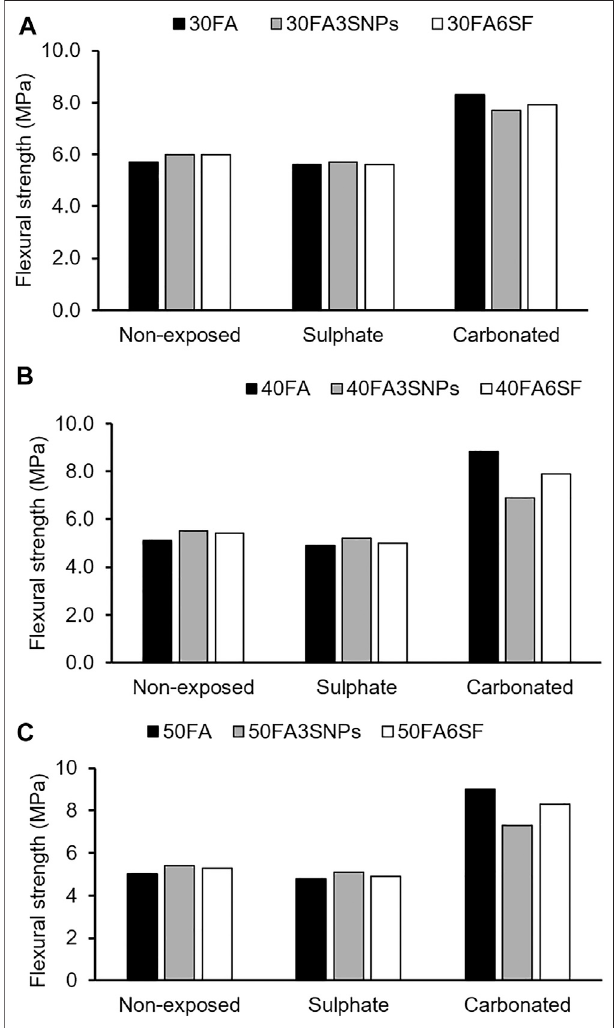
FIGURE 4 | The fl exural strength of exposed and non-exposed (A) 30% fl y ash containing 3% SNPs and 6% SF (B) 40% fl y ash containing 3% SNPs and 6%SF and (C) 50% fl yash containing3%SNPs and 6%SFincorporated concrete samples after 365 days of